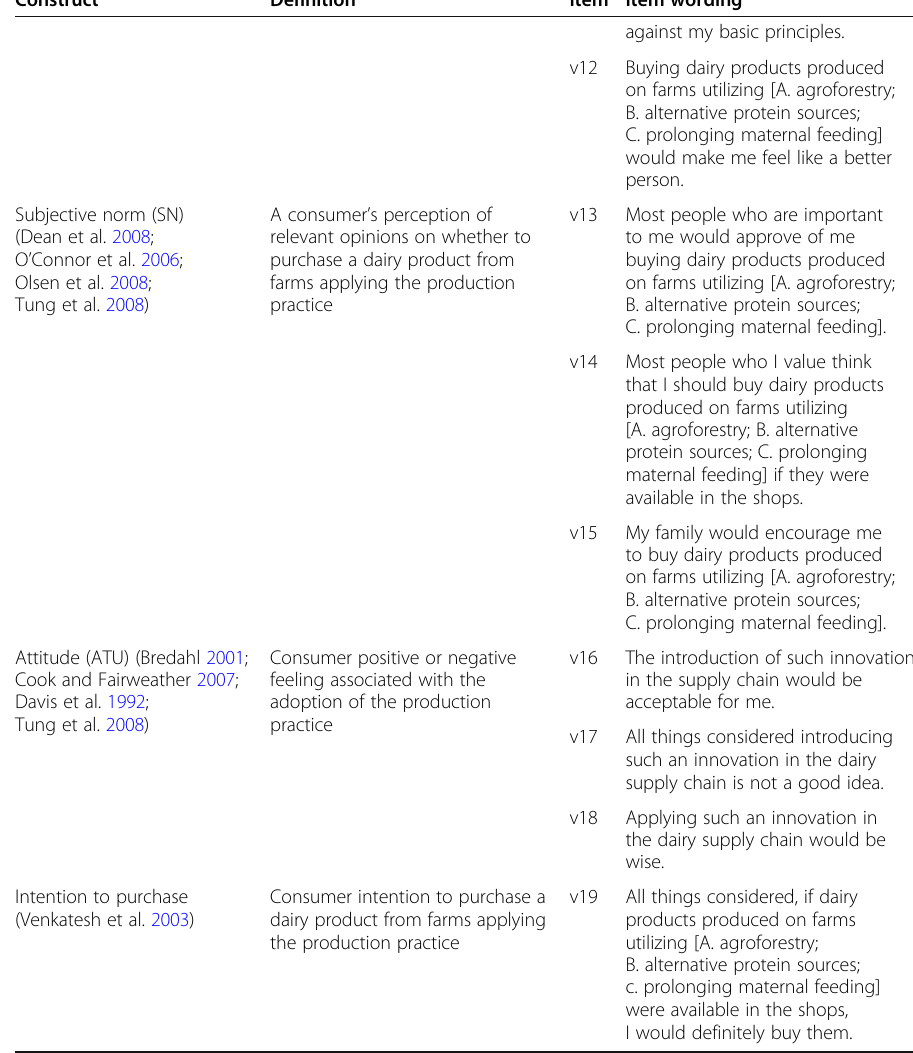
Table 1 Definition of the multi-item constructs (original items)